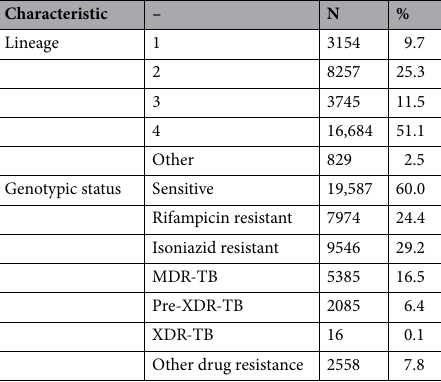
Table 1. Mycobacterium tuberculosis isolates analysed (n = 32,669). MDR-TB = multi-drug resistant; XDR-TB = extensively drug